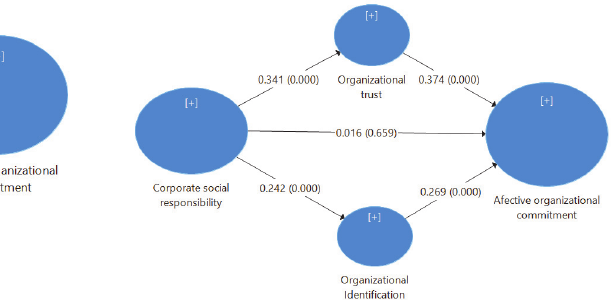
Fig. 3. Direct impact test Fig. 4. Testing intermediary